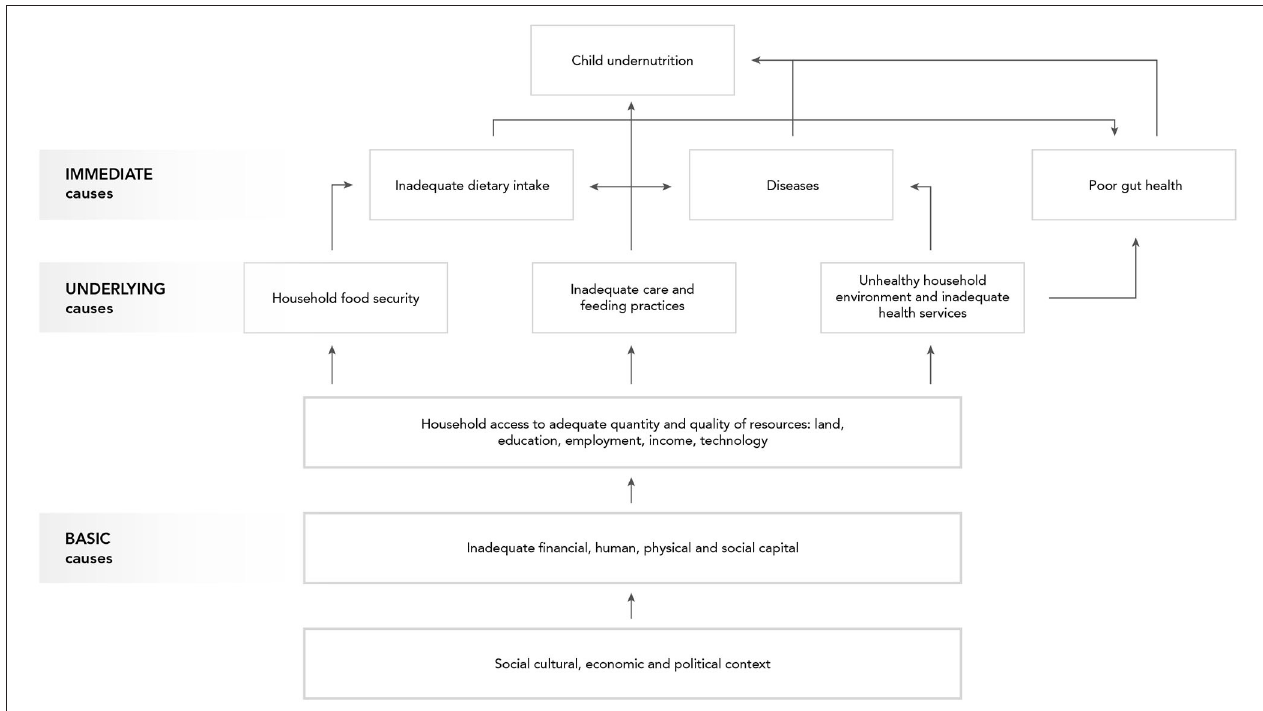
FIGURE 2 | Modified framework for child